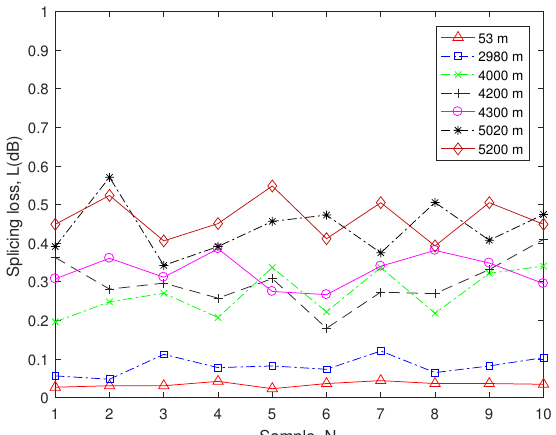
Figure 9. Splice loss versus samples, In the high altitude environment at different altitudes, under the same conditions, the ULL optical fibers have been fused on site, and 10 samples have been taken from each experimental point, and then the average value of the results has been taken.